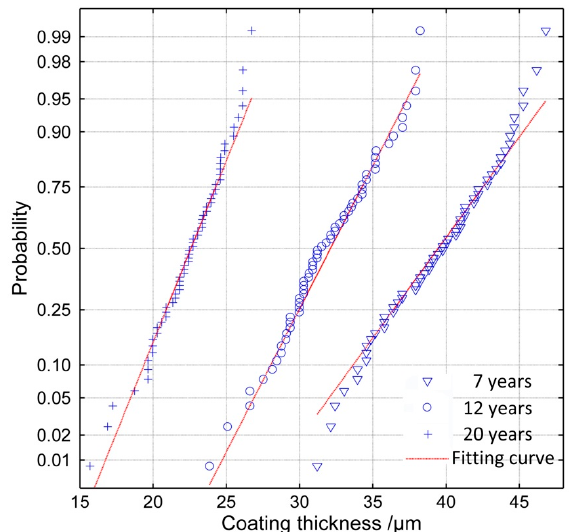
Figure 6. Result of the probability paper test of normal distribution (20 years’ data from coating-still-existing areas).